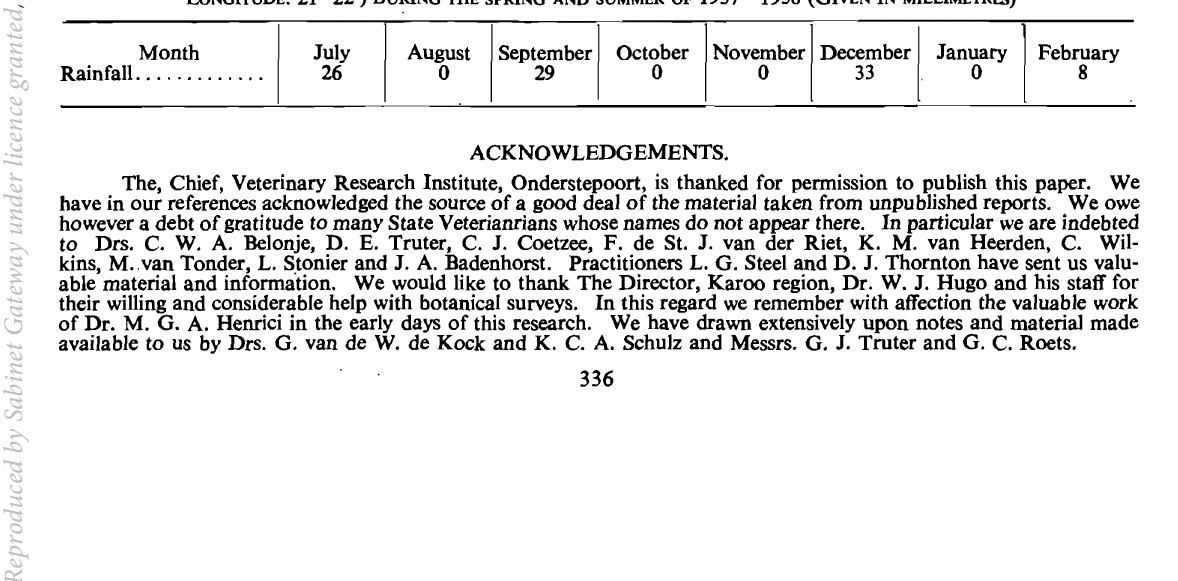
TABLE 4.-MONTHLY VARIATIONS IN THE RAINFALL RECORDED AT HONDEFONTEIN METEOROLOGICAL POST. (LATITUDE 32" 13', LoNGITUDE. 21022') DURING THE SPRING AND SUMMER OF 1957-1958 (GIVEN IN